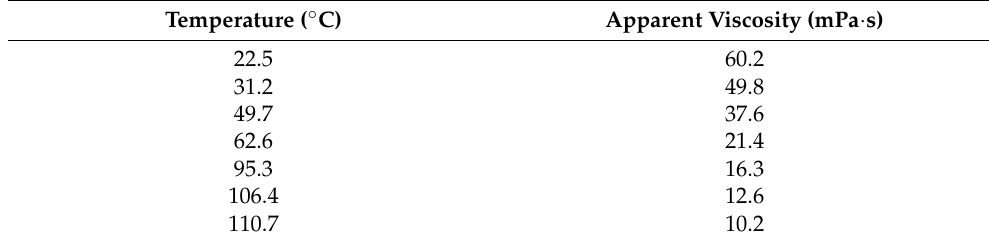
Table 2. Base fluid viscosity test at different temperatures.